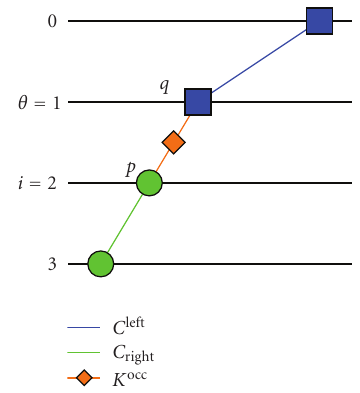
Figure 3: Example of the components of C local